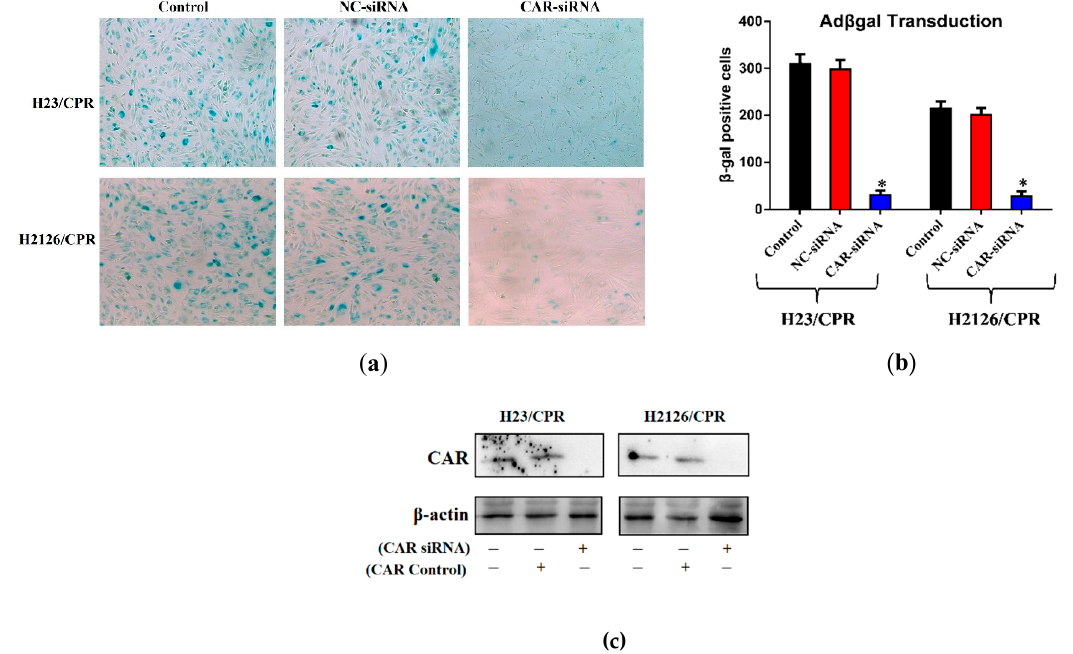
Figure 2. CAR knockdown and adenoviral transduction efficacy. ( a ) Both lung cancer cell lines were evaluated for CRAd infection efficacy through X-gal staining. Lung cells were cultured in 6-well plates and treated with different Ad β gal doses. After 48 h, all cells were washed, fixed, stained and photographed via phase contrast microscope 100 × magnification. ( b ) Resistant cells exhibit higher rates of transduction and siRNA medicated CAR knockdown significantly reduces the infectivity. ( c ) Western blots showing CAR overexpression in resistant sublines of lung cancer cells and CAR knockdown by employing CAR siRNA. Data are presented in ( b ) as the mean ± SD, ( n = 3), * p < 0.01, by two-tailed Student’s t-test.